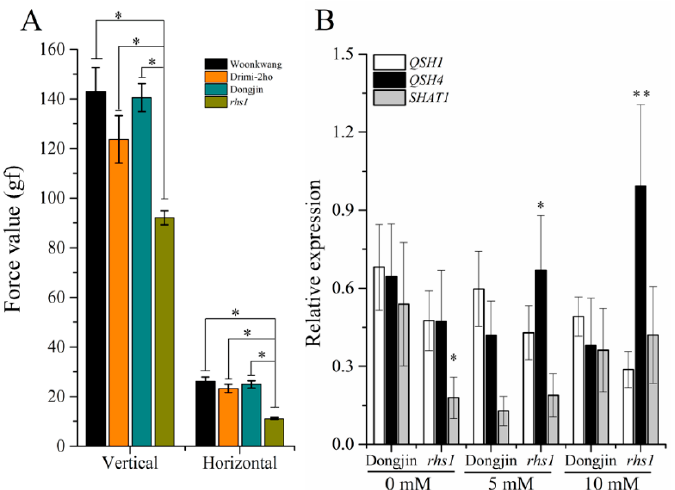
Figure 1. RHS1 regulates seed-pod shattering in rice. The seeds of the rhs1 plants showed significantly lower force values in terms of the vertical and horizontal force required to mechanically detach them from the base of the spikelet ( A ). A significant variation was observed in the expression of shattering-related genes in the rhs1 plants under normal and nitrosative stress conditions ( B ). Each data point represents the average of three data points. Means were analyzed for significant difference using the Student’s t-test. Error bars represent the standard deviation. Significant differences are represented by asterisk (*) and (**) at p < 0.05 and p < 0.01, respectively.